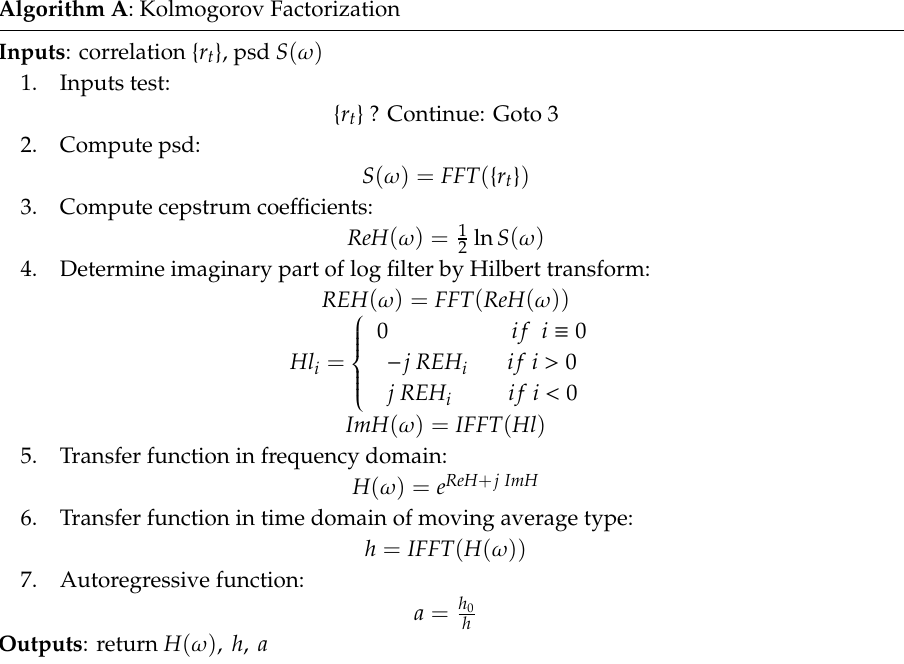
Algorithm A : Kolmogorov